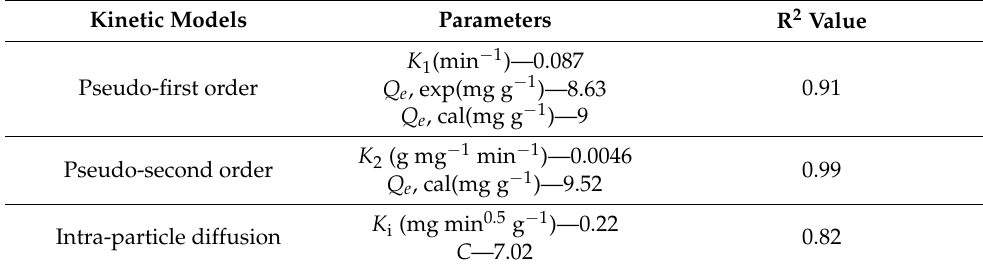
Figure 5. Kinetics of the PNB–MB adsorption system by: ( a ) pseudo-first order model; ( b ) pseudo-second order model; and ( c ) intra-particle diffusion model. Table 2. Methylene blue adsorption parameters for different kinetic